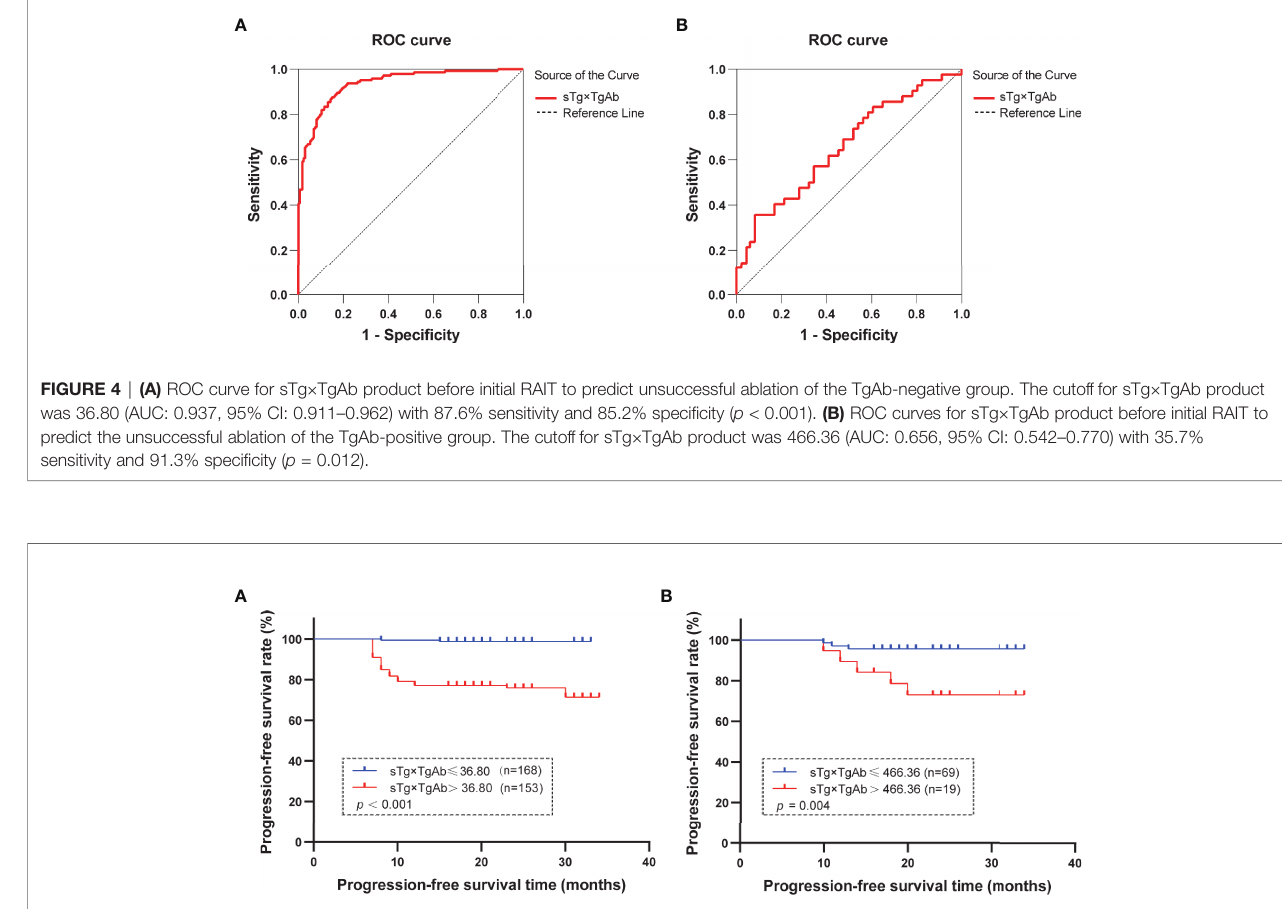
FIGURE 5 | (A) TgAb-negative group: mean PFS in the group of patients with sTg×TgAb ≤ 36.80 or >36.80. The PFS was 32.74 months with sTg×TgAb ≤ 36.80 and 27.82 months for sTg×TgAb > 36.80 ( p < 0.001). (B) TgAb-positive group: mean PFS by group of patients with sTg×TgAb ≤ 36.80 or >36.80. The PFS was 33.01 months with sTg×TgAb ≤ 466.36 and 28.84 months for sTg×TgAb >466.36 ( p = 0.004).